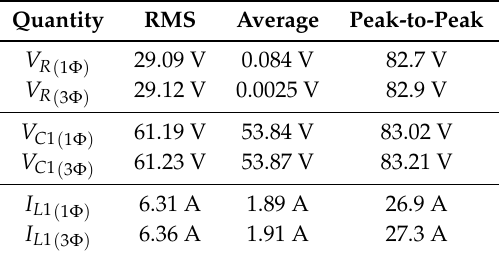
Table 2. RMS (root mean square), average and peak-to-peak values for the simulated currents and voltages: R load.